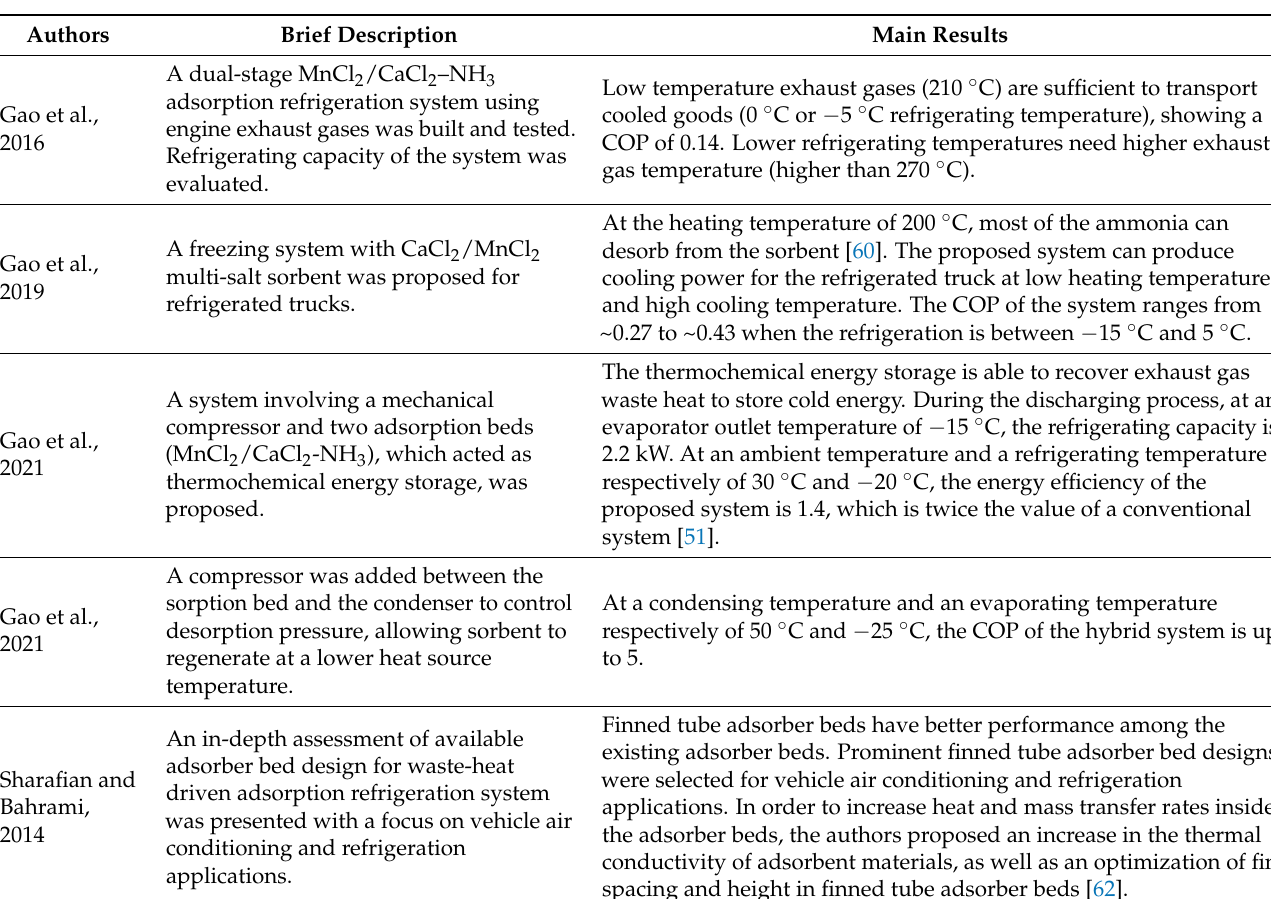
Table 8. Summary of proposed adsorption refrigeration systems in refrigerated transport